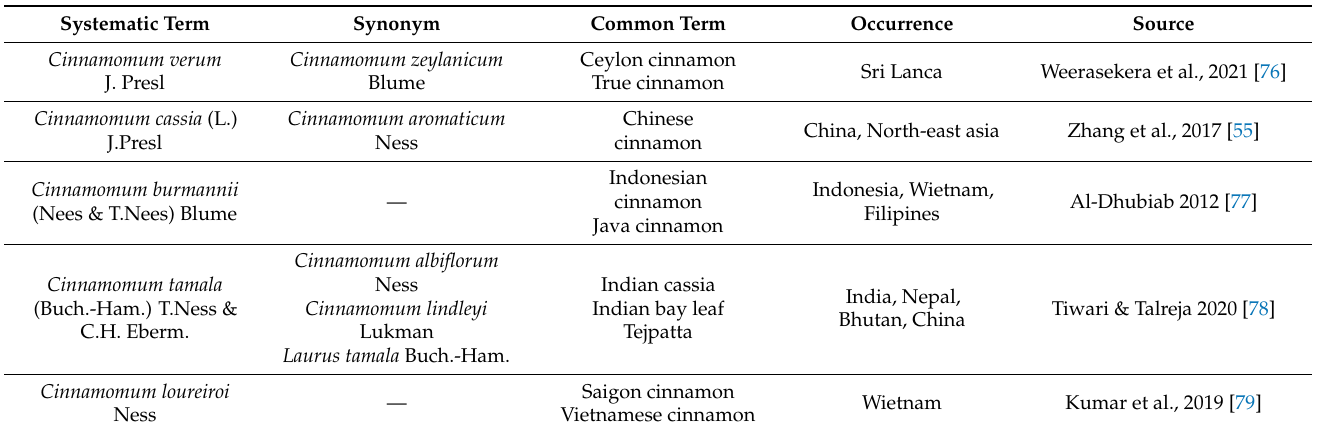
Table 2. Main varieties of cinnamon for medicinal and seasoning purposes.